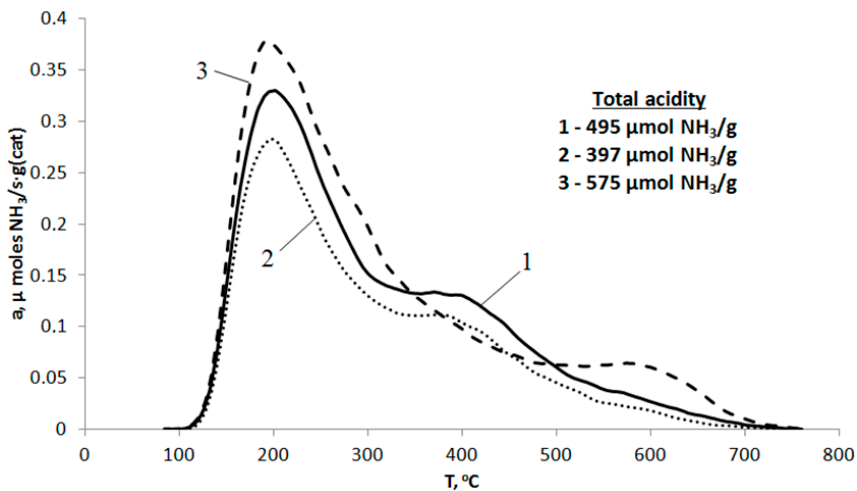
Figure 3. NH 3 TPD profiles of hydrothermally treated HZSM-5 / Al 2 O 3 , Zr-, and Mg-modified samples. 1—HZSM-5 / Al 2 O 3 , 2—Zr-HZSM-5 / Al 2 O 3 , 3—Mg-HZSM-5 / Al 2 O 3 .